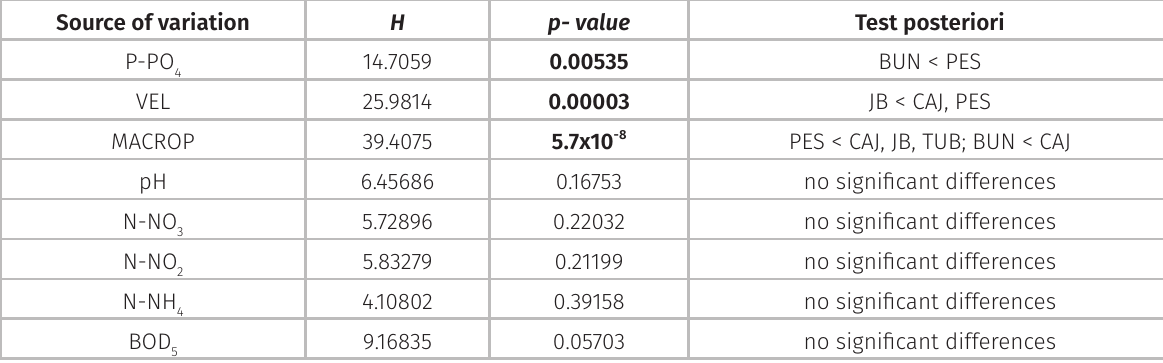
Table IV. Kruskal-Wallis non parametric test on the physicochemical and hydrological variables recorded at the sampling sites. In bold type, the significant p values (p ≤ 0.05) and the corresponding post-hoc